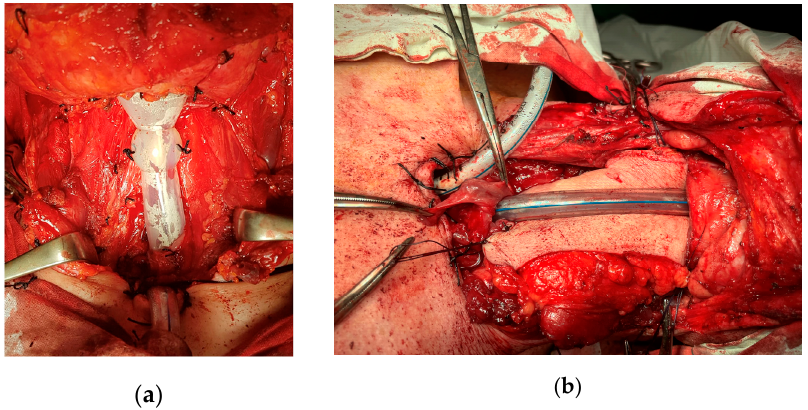
Figure 9. Intraoperative images. ( a ) Reconstruction of the pharynx with bypass salivary tube. ( b ) Reconstruction of the pharynx with myocutaneous major pectoralis muscle flap.